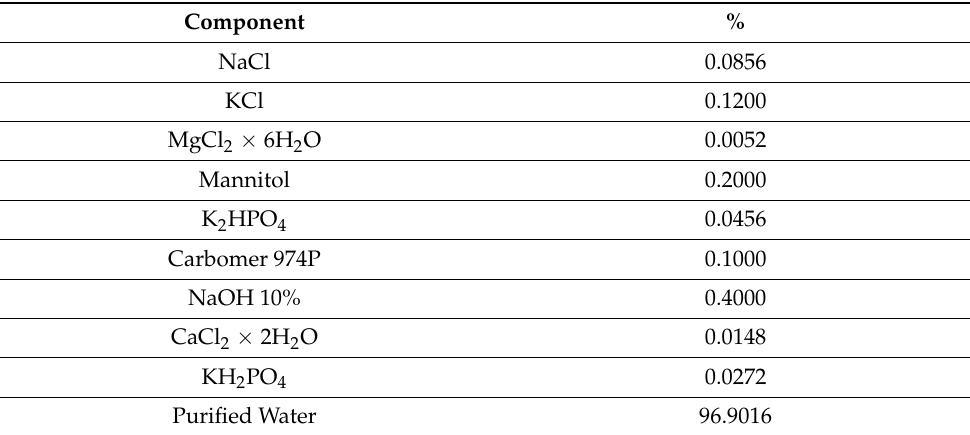
Table 2. Composition of the artificial saliva, used in this study.